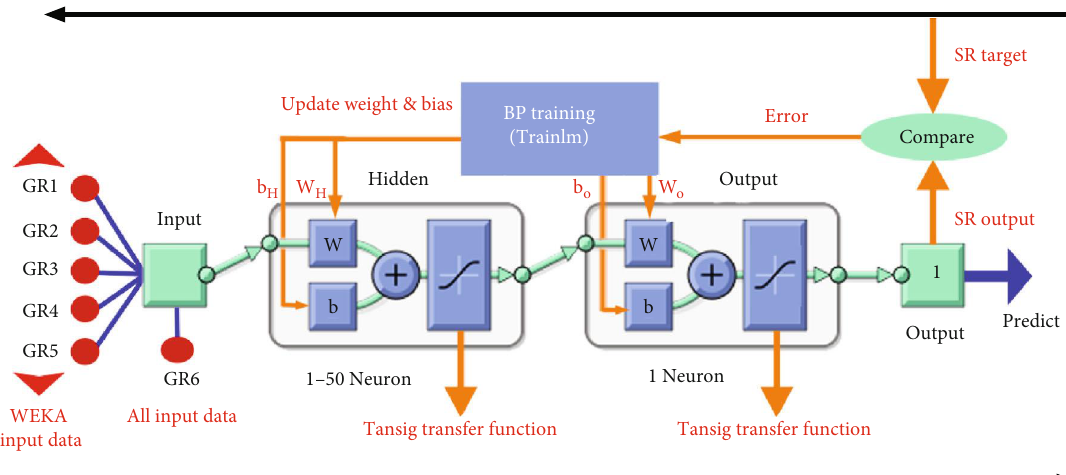
Figure 5: Architectural structure of MFFNN used in